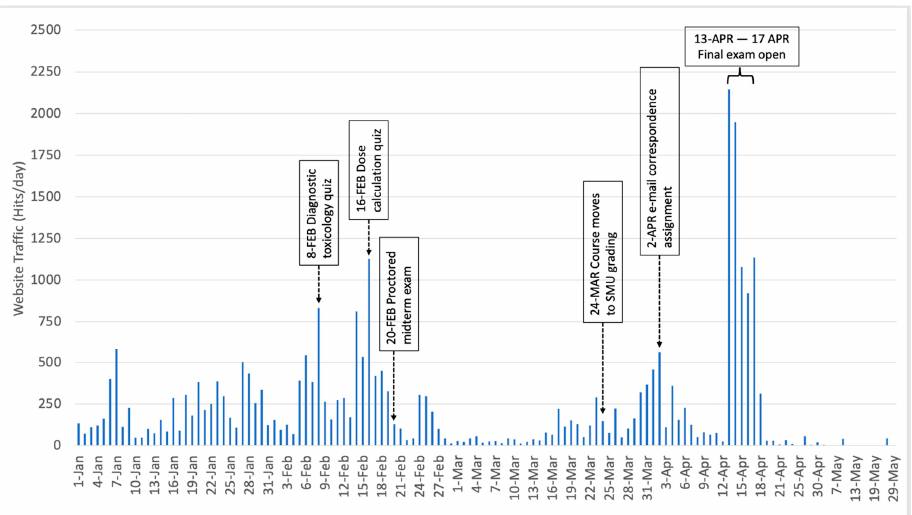
Figure 1. Total number of hits per day on course learning management system (LMS) site for online toxicology course, along with corresponding milestone events. Note that Spring Break occurred 14–22 March 2020. SMU: satisfactory, mar- ginal, unacceptable.